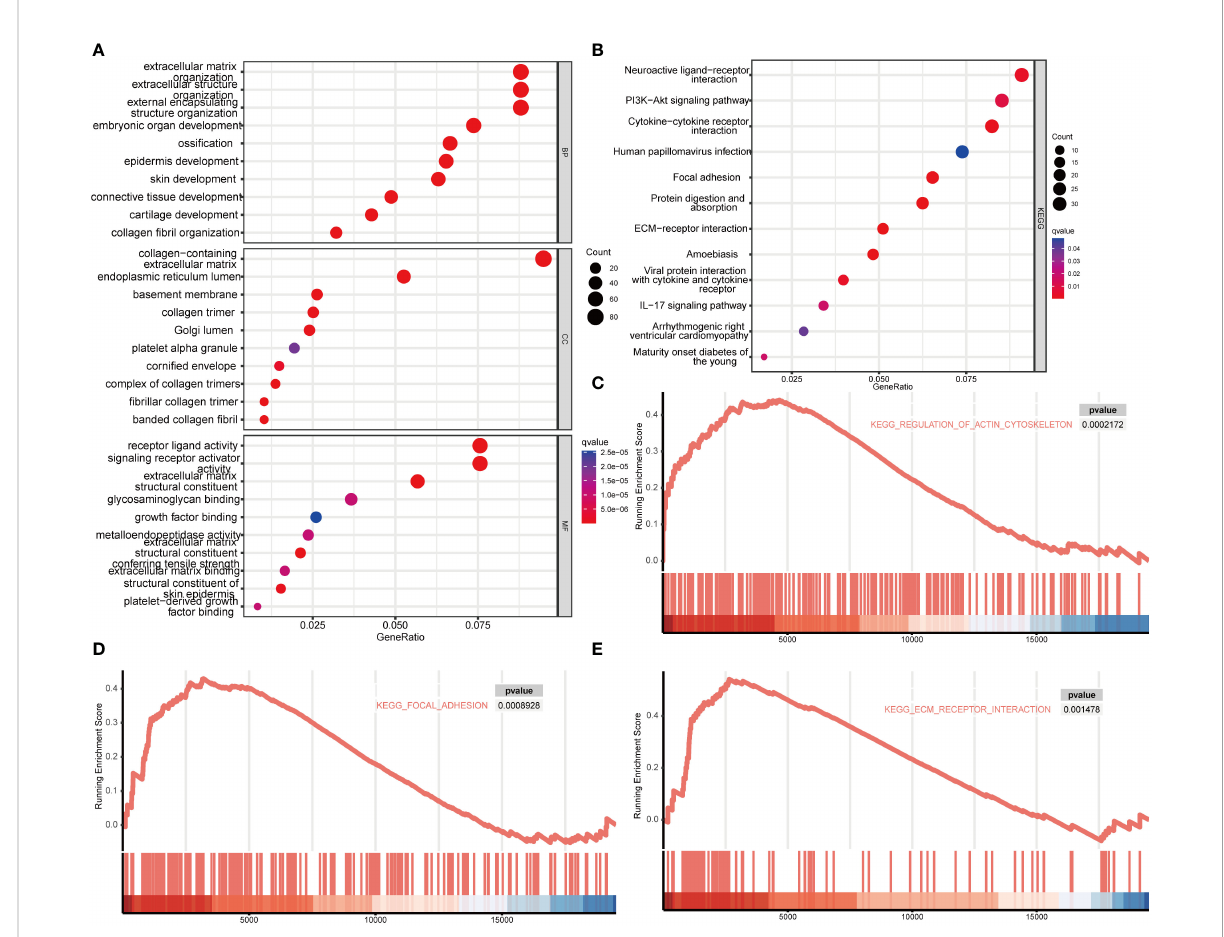
FIGURE 5 Enrichment analysis of MDFI in LUAD, data from TCGA. (A) GO. BP/CC/MF enrichment analysis, (B) KEGG enrichment analysis, (C – E) GSEA enrichment